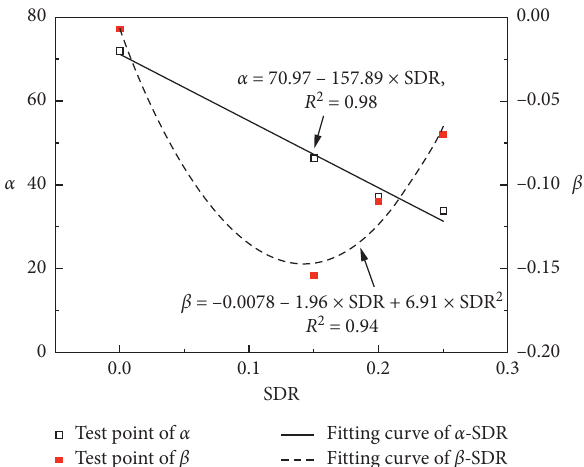
Figure 11: Variations of parameters α and β with different SDR.